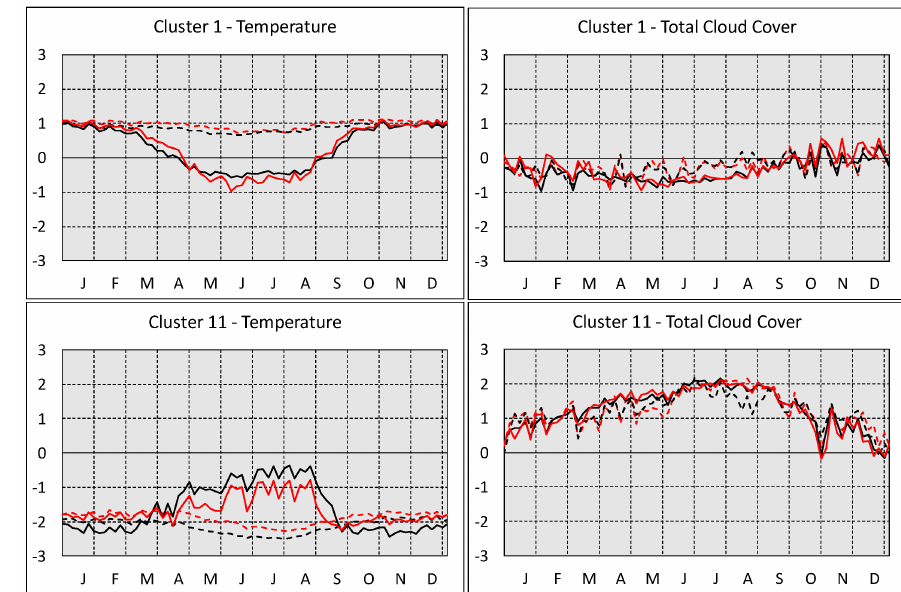
Figure 12. The mean intra-annual variations of the spatial anomalies of air temperature and total cloud cover for clusters 1 and 11. Black lines represent the ERA5 dataset while red lines represent the ERA-Interim dataset. Solid and dashed lines correspond to 12UTC and 00UTC,